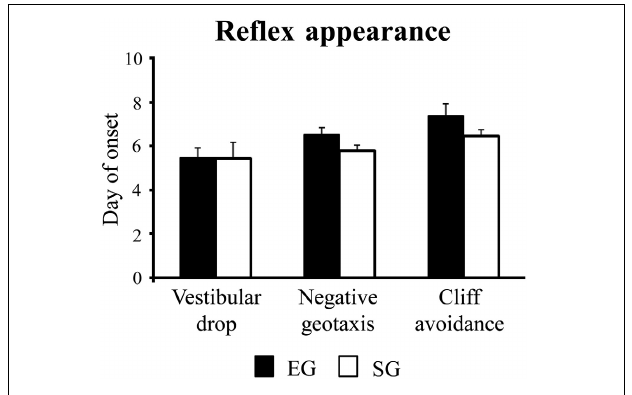
FIGURE 3 | Results of pre-reproductive maternal rearing condition on reflex appearance. Day of onset of vestibular drop, negative geotaxis, and cliff avoidance. Results are reported as mean ± s.e.m.